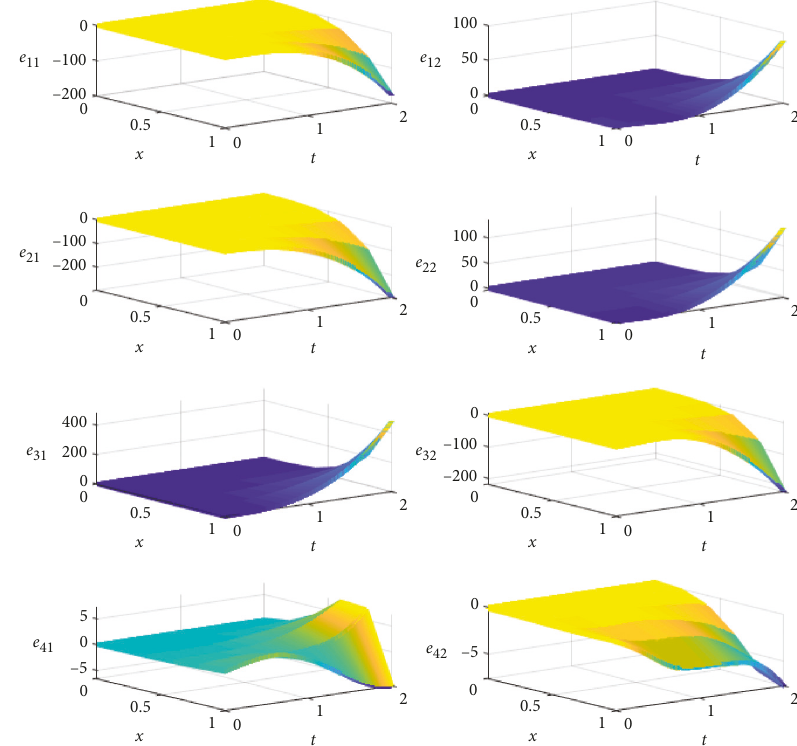
Figure 1: The open-loop profile of z